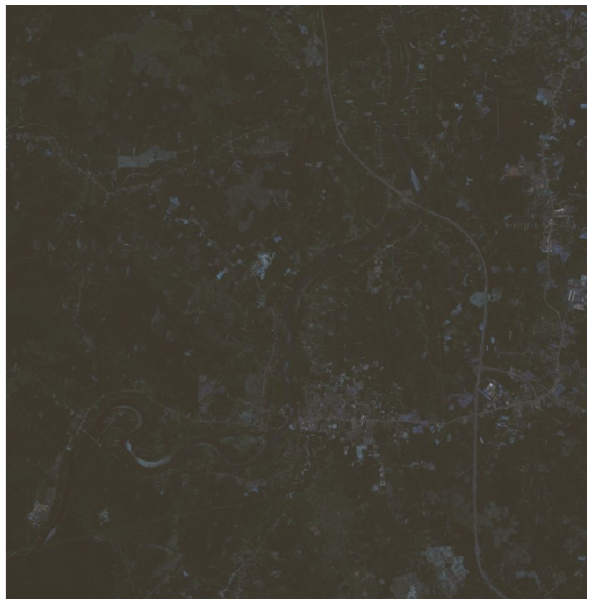
Figure 3.a: Example for 660x660 pixels original image